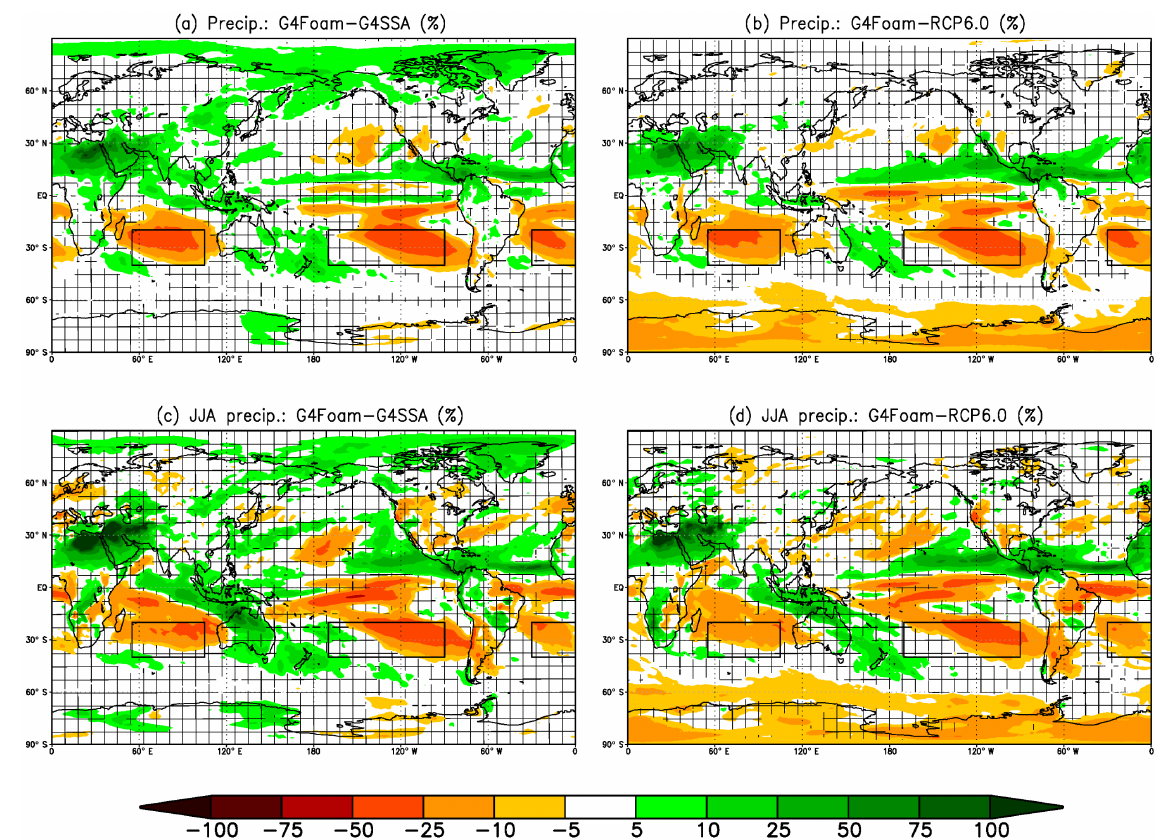
Figure 7. 2030–2069 precipitation difference (%) between G4Foam and (a) G4SSA, (b) RCP6.0, (c) G4SSA during JJA, and (d) RCP6.0 during JJA. Hatched regions are areas with p >0.05 (where changes are not statistically significant based on a paired t test). Black boxes enclose foamed